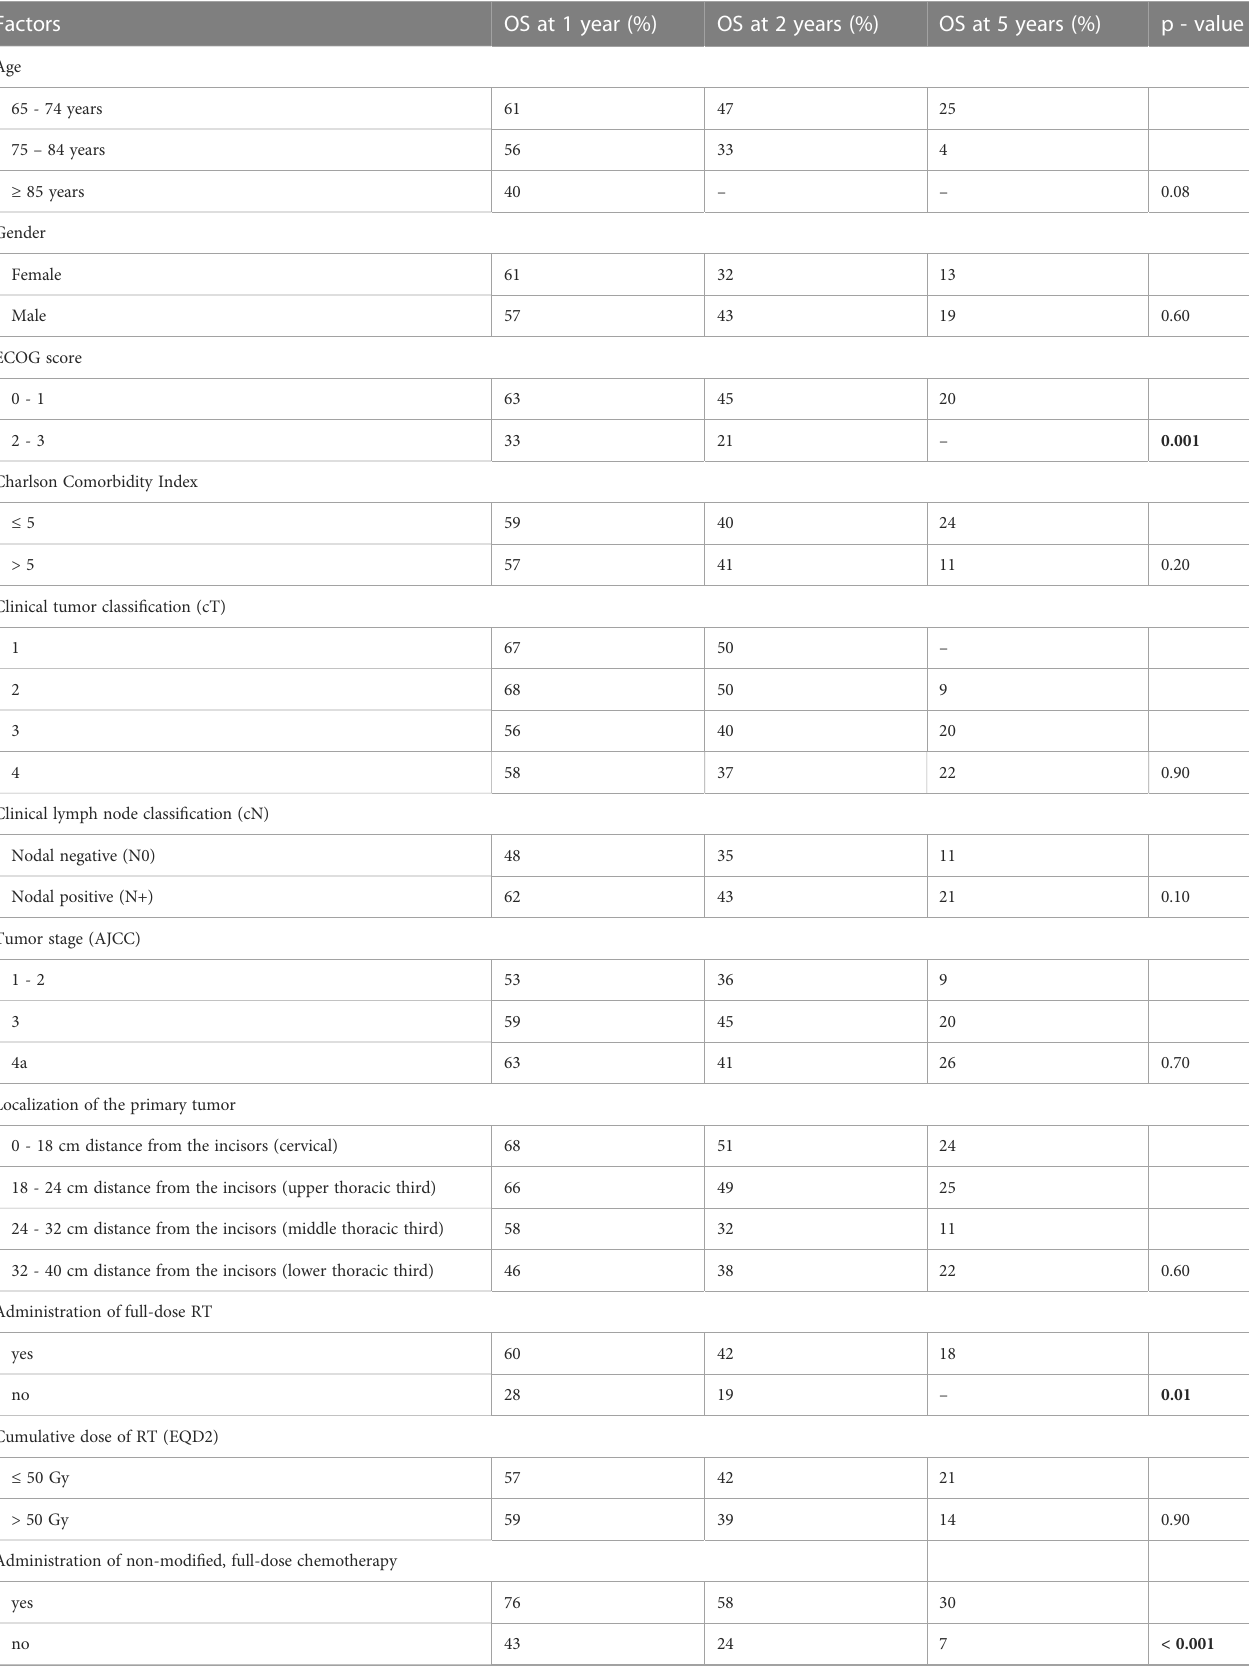
TABLE 2A Univariate analyses of potential prognostic factors for overall survival (OS).